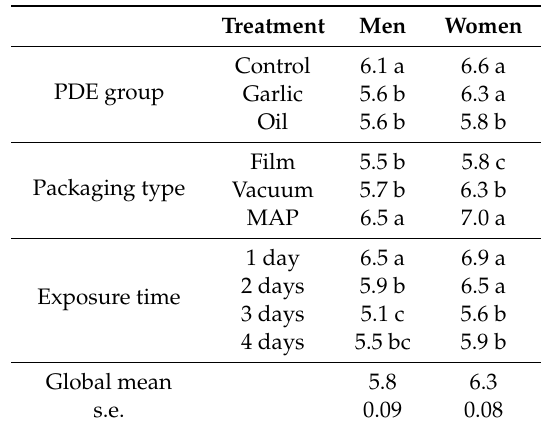
Table 4. The means and standard error of studied e ff ects (consumer’ gender and age) on visual appraisal scores of pork